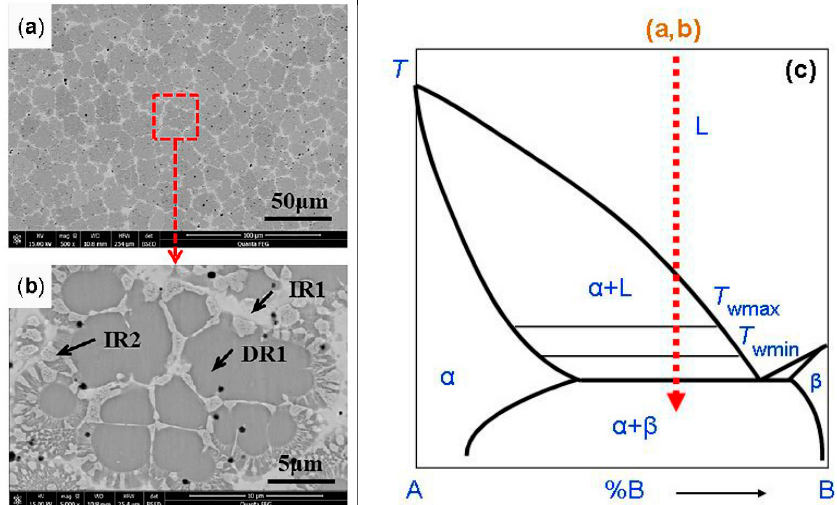
Figure 4. ( a ) The microstructure of the cross-section of an AlCoCrFeNiTi 0.5 coating. ( b ) Local magnified view of dotted frame in ( a ). ( c ) Schematic phase diagram with GB wetting tie-lines. The dotted red arrow shows the cooling trajectory corresponding to the micrographs ( a , b ). Micrographs ( a , b ) are reprinted with permission from Ref. [62]. Copyright 2021 Elsevier.